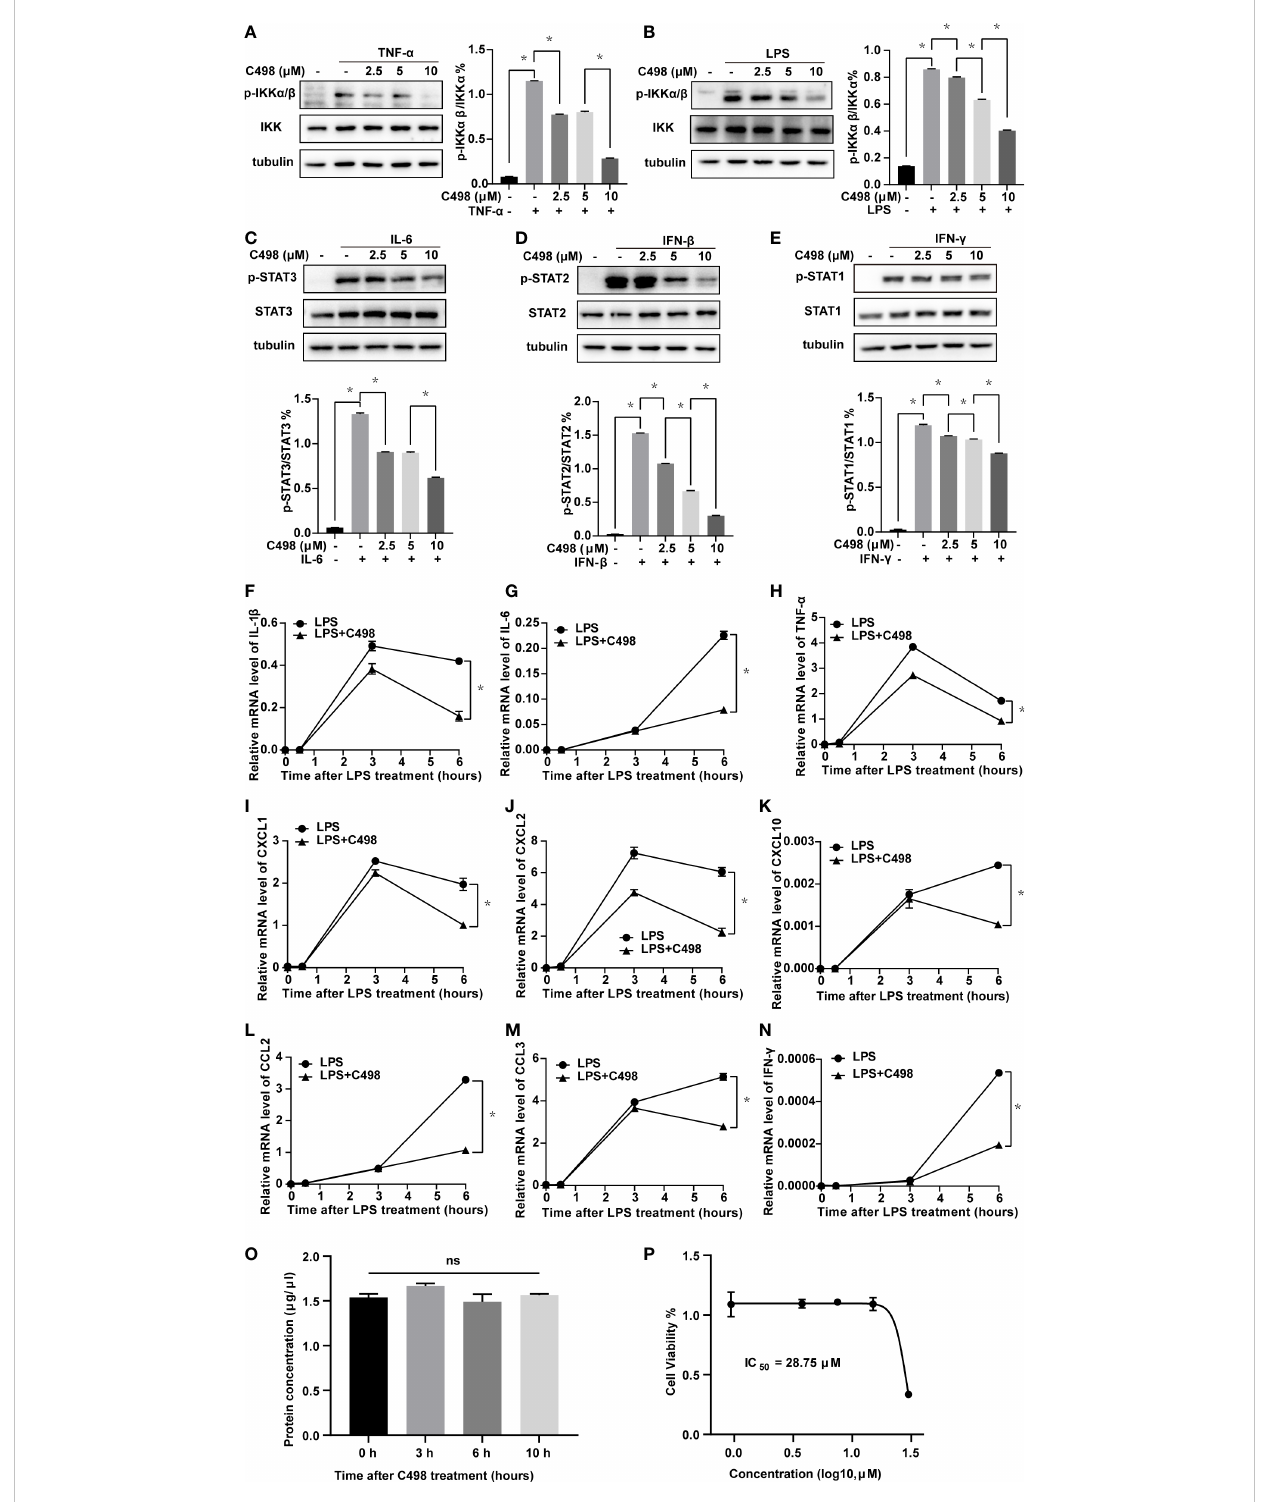
FIGURE 2 C498 inhibits JAK/STAT and NF k B signaling pathways and downstream gene expression in mouse peritoneal macrophages. (A-E) Peritoneal macrophages were isolated and treated with DMSO or C498 at 2.5, 5, and 10 m M for 2 h, followed by stimulation with 20 ng/ml TNF- a for 10 min or 100 ng/ml LPS for 0.5 h ( A , B ), 20 ng/ml IL-6 (C) , 50 ng/ml IFN- b and IFN- g ( D , E ) for 10 min. Western blot analysis of whole cell lysates and quantitative analysis were determined with primary antibodies including anti-pSer176/180-IKK a / b and anti-IKK ( A , B ), anti-pTyr705-STAT3 and anti- STAT3 (C) , anti-pTyr690-STAT2 and anti-STAT2 (D) , anti-pTyr701-STAT1 and anti-STAT1 (E) . F-N, Peritoneal macrophages were pretreated with DMSO or C498 (5 m M) for 30 min and then stimulated with 150 ng/ml LPS for additional 0, 0.5, 3, and 6 h. The relative mRNA levels of IL-1 b (F) , IL-6 (G) , TNF- a (H) , CXCL1 (I) , CXCL2 (J) , CXCL10 (K) , CCL2 (L) , CCL3 (M) and IFN- g (N) were determined by RT-PCR. (O) Peritoneal macrophages were treated with 5 m M C498 for 0, 3, 6 and 10 h, cell lysates were harvested, and protein concentrations were determined. (P) Peritoneal